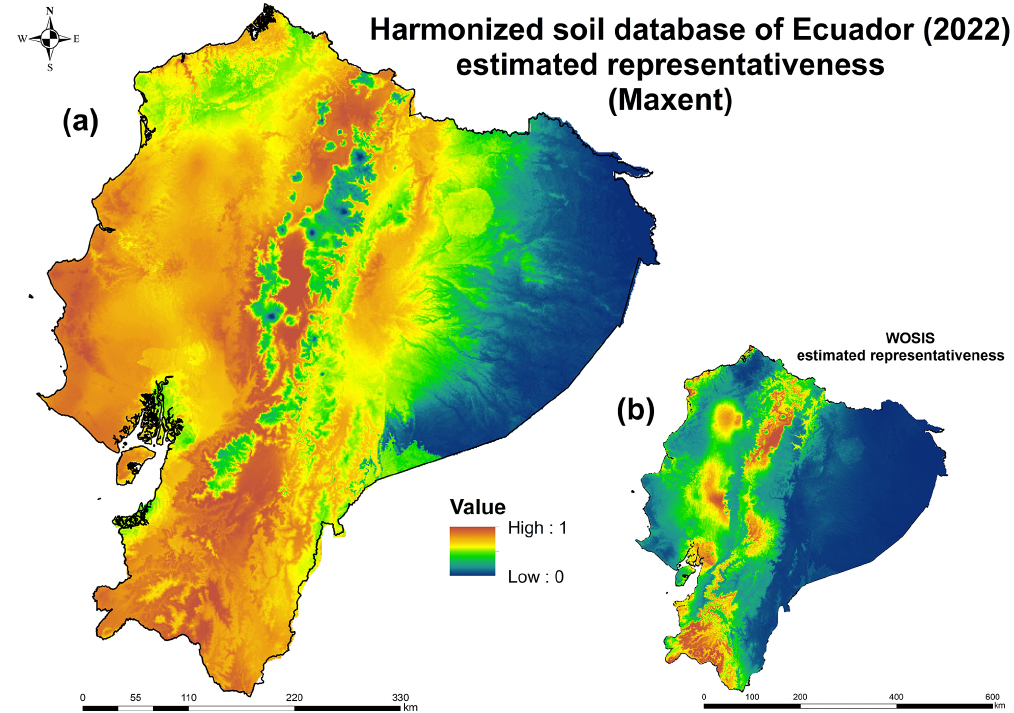
Figure 5. (a) National representativeness (an estimate between zero and one of the probability of the presence) of soil information using the HESD. (b) Information available on the national representativeness of soil information from the World Soil Information Service